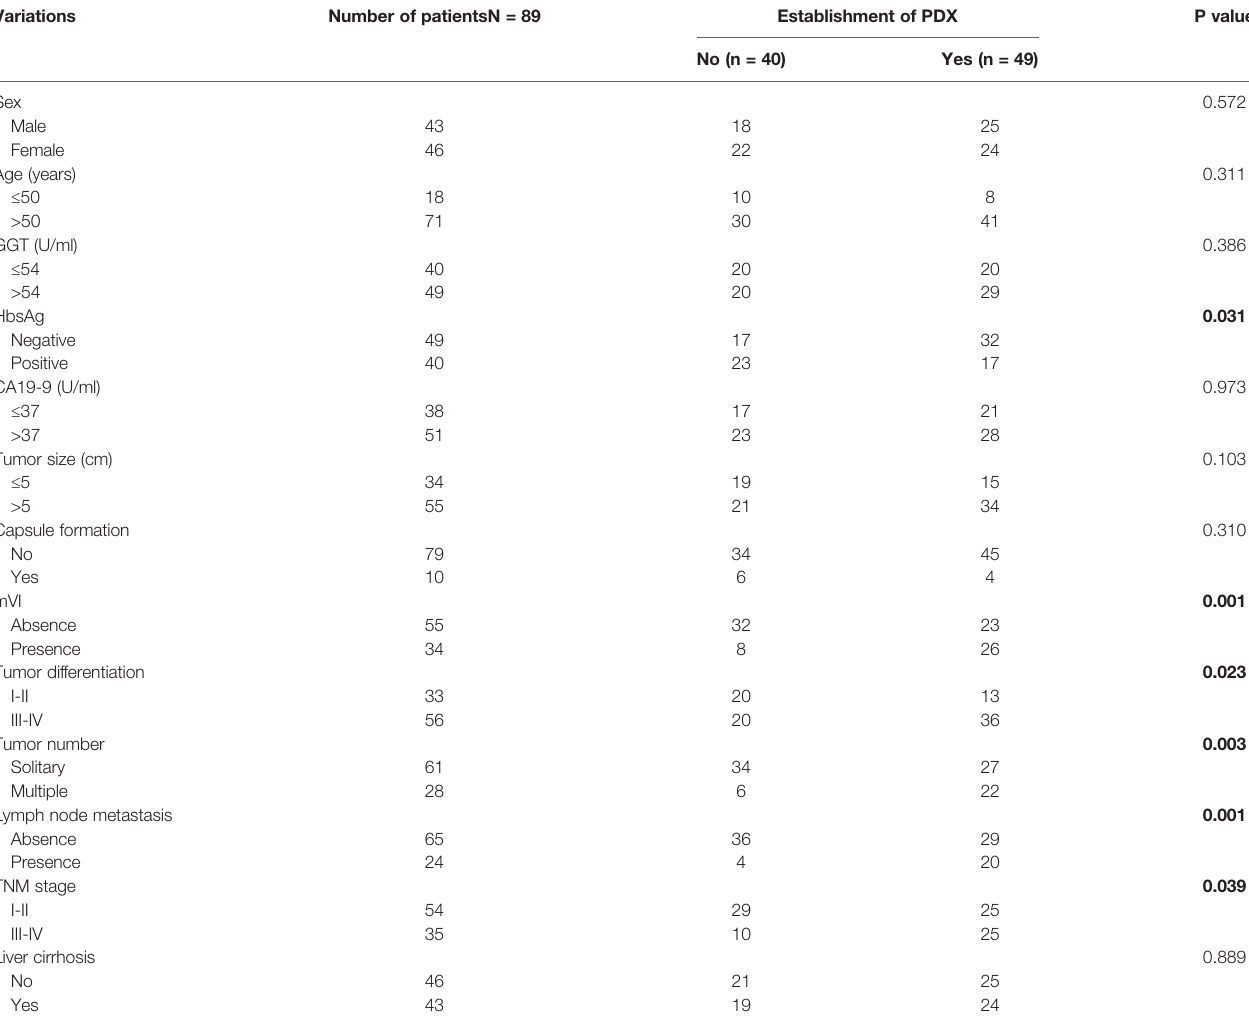
GGT,Glutamyltranspeptidase;HBsAg,hepatitisBsurfaceantigen;CA19-9,carbohydrateantigen19-9;mVI,microvascularinvasion;TNM,tumor-node-metastasis;PDX,patientderived xenograft; NA, not applicable. Statistically signi fi cant (P < 0.05) values are in